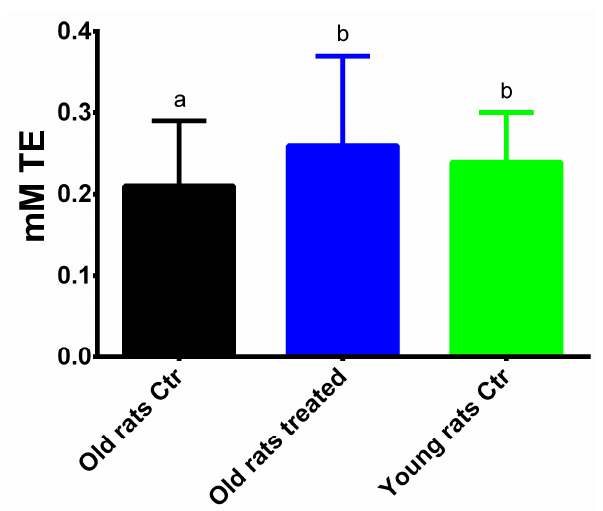
Figure 3. Antioxidant capacity determined with the FRAP assay in muscles of rats. Results are expressed as mean ± SEM, and p < 0.05 was considered statistically significant. Statistical significance was calculated by one-way ANOVA analysis. Di ff erent letters reveal significant di ff erences. Old rats Ctr refers to old animals treated with placebo; Old rats treated refers to old animals treated with Taurisolo ® ; Young rats Ctr refers to young animals treated with placebo.